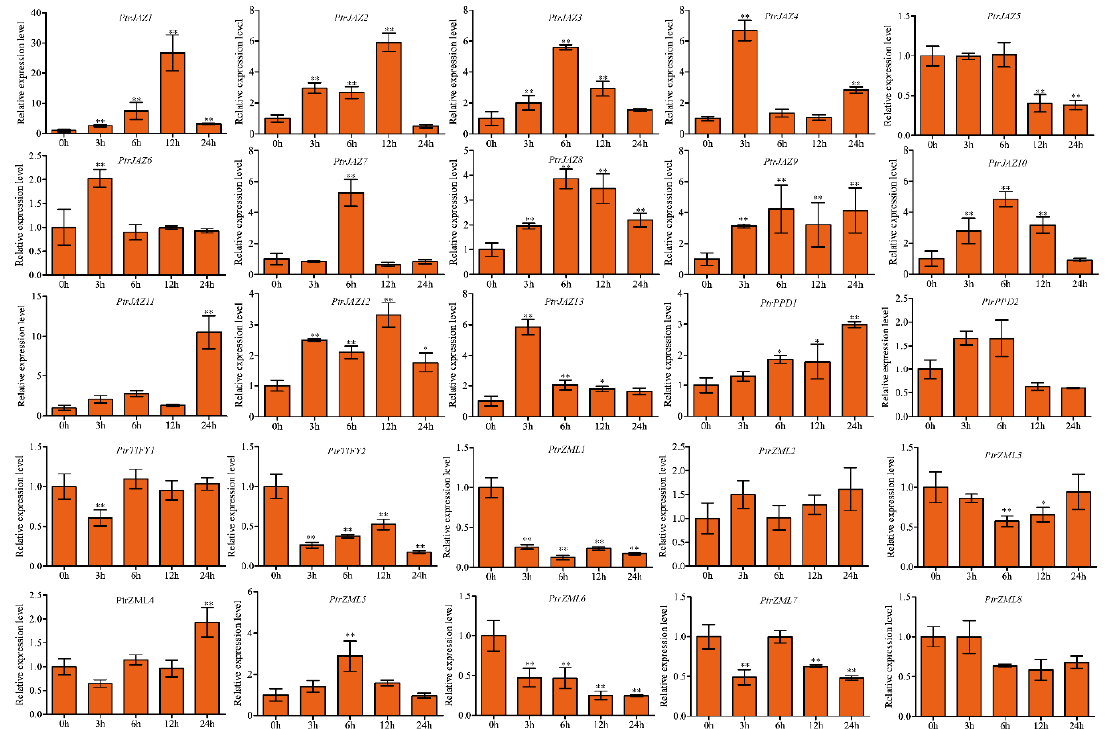
Figure 9. Expression analysis of PtrTIFY genes in root under 100 μ M SA treatment by qRT–PCR. Error bars represent the standard deviations from three biological replicates. Asterisks indicate stress treatment groups that showed a significant difference in transcript abundance compared with the control group (* p < 0.05, ** p < 0.01).